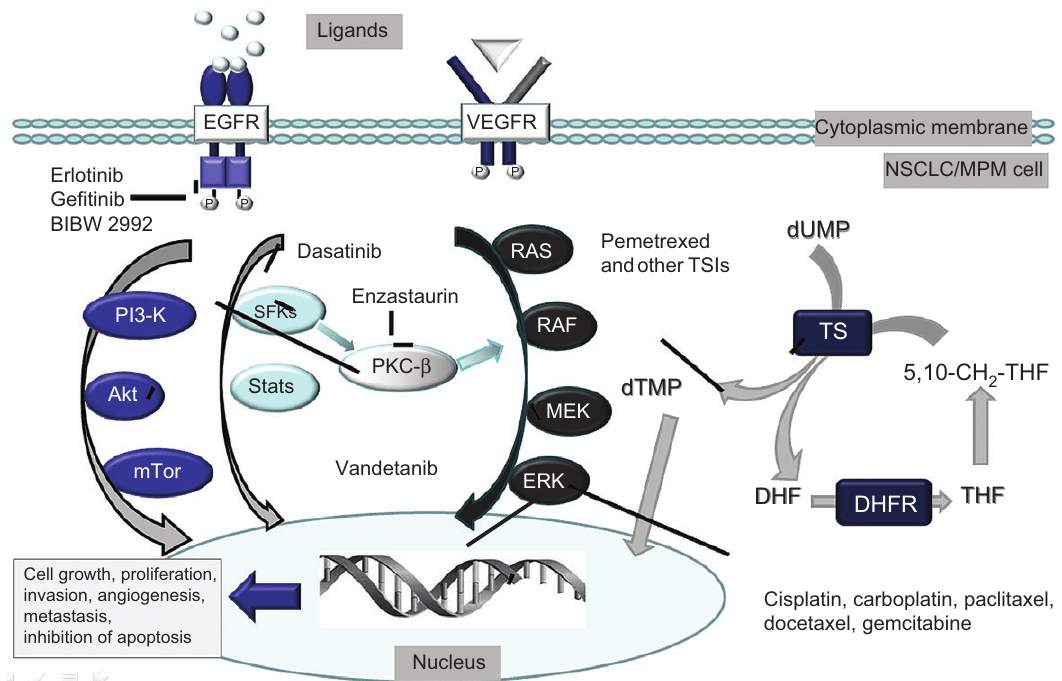
Figure 3 Interaction between PMX and signaling and DNA targeted